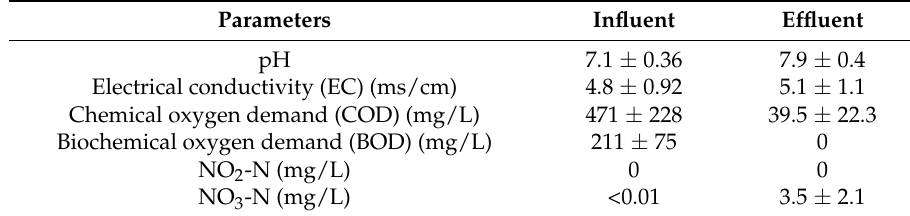
Table 1. Membrane bioreactor (MBR) influent and effluent parameters.